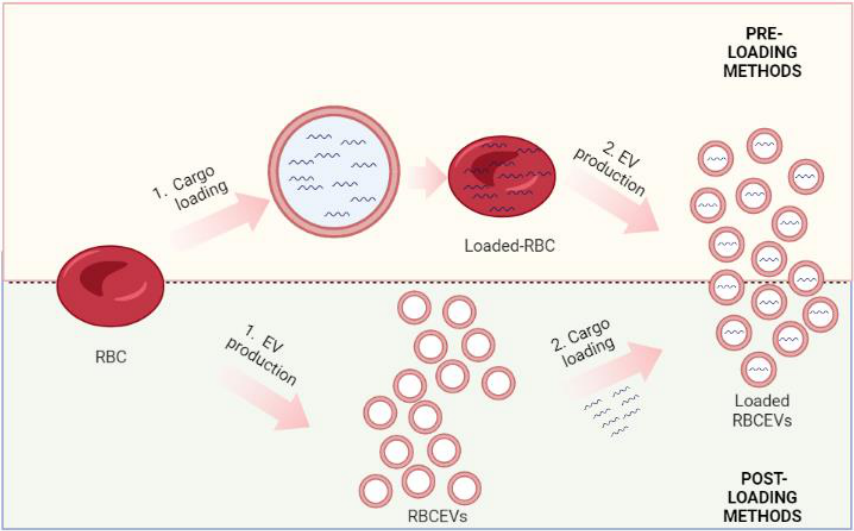
Figure 5. Methods for cargo loading in RBCEVs. Loading methods have been divided into two main classes, namely pre-loading and post-loading methods. In the first, the cargo is loaded into the donor cell before the vesiculation process. While, in the second method, the cargo is loaded into the already produced vesicles. Created in Biorender.com, accessed on 9 January 2023.